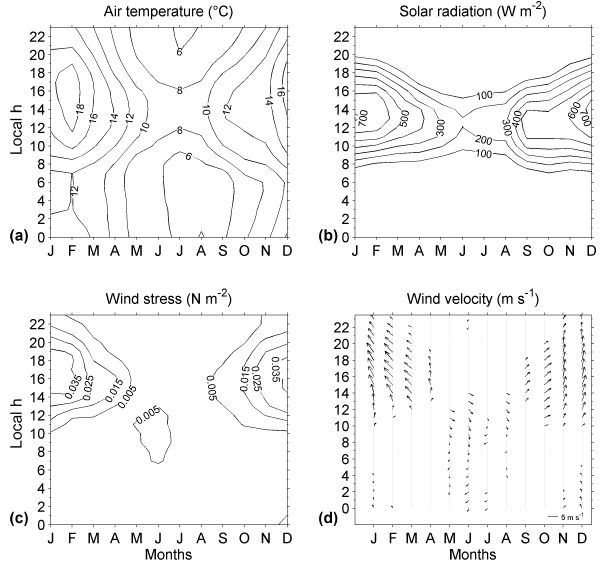
Figure 3. Seasonal variability in the daily cycle of the meteorologi- cal variables: (a) air temperature, (b) solar radiation, (c) wind stress magnitude and (d) wind velocity (meteorological convention). The y axis is the local hour to be consistent with the daylight hours.